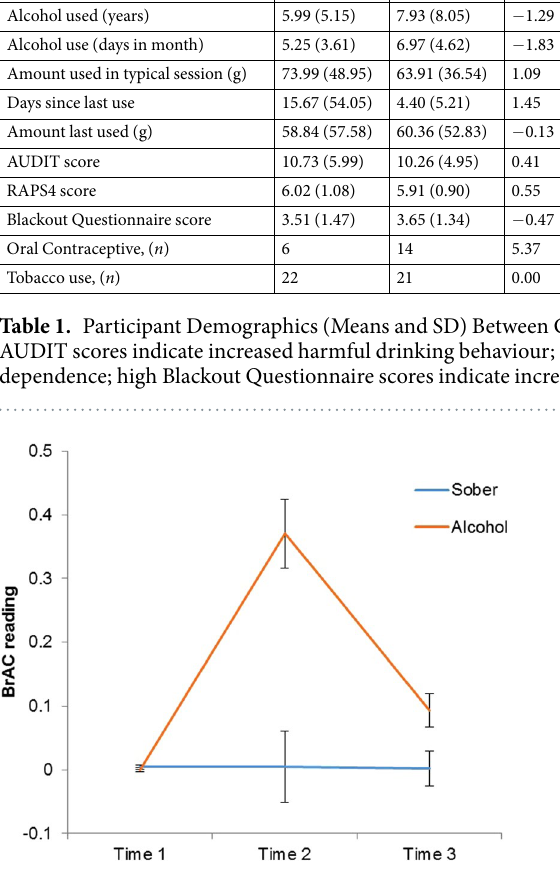
Figure 3. The average breath alcohol content (BrAC) readings for both the alcohol and sober conditions at three different time points (before drinking; following drinking; the morning after drinking) throughout the duration of the experiment, with standard error bars. There were significant differences between groups following drinking, both at time two ( p < 0.001) and time three ( p < 0.001). There were no significant group differences before